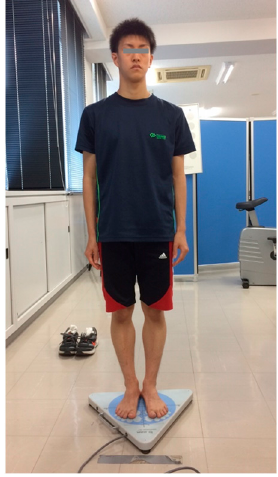
Figure 3. Measurement of the standing postural control function using a gravity center fluctuation meter.